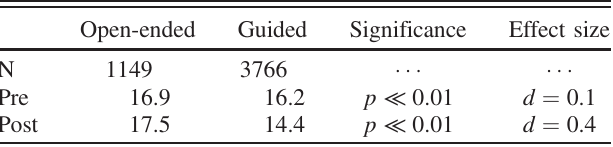
TABLE III. Overall E-CLASS scores (points) for students in courses using open-ended activities and those using only tradi- tional guided labs in the full, aggregate data set ( N ¼ 4915 ) on both the pre- and post-tests. Significance indicates the statistical significance of the difference between students ’ scores in the open-ended and guided lab only